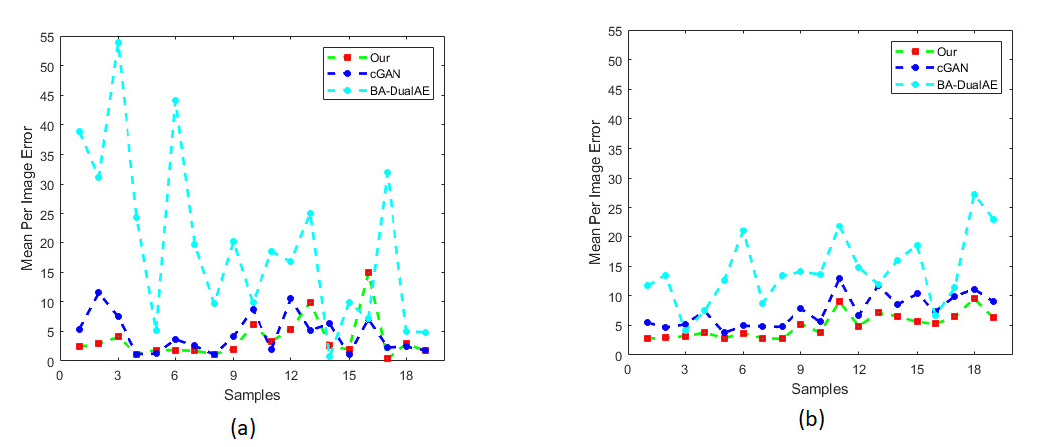
Figure 7. Per-image MSE of randomly selected input test samples from the ( a ) NYU dataset and ( b ) Cityscapes dataset. The green plot shows the MSE of each input sample, and the blue and cyan plots represent the MSEs from cGAN [10] and BA-DualAE [28],